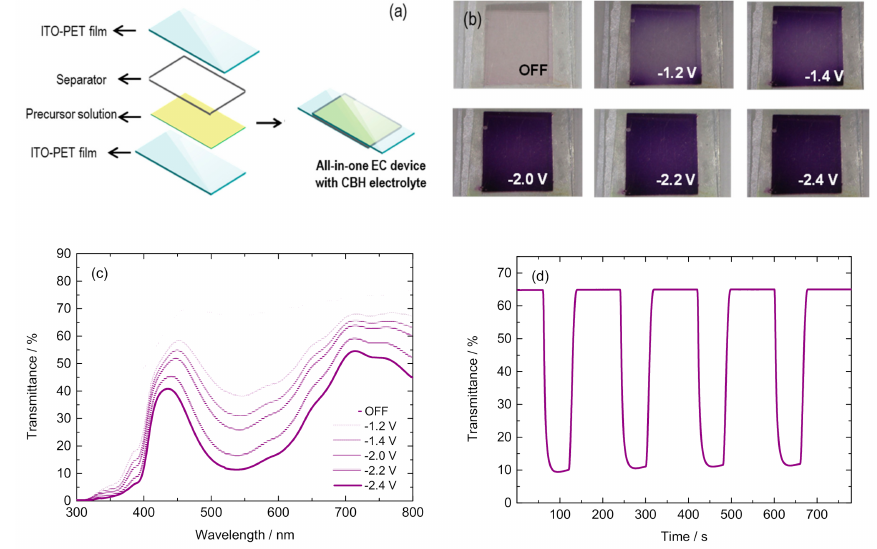
Figure5. Electrochromicperformanceofcellulose-basedhydrogels(CBHs): ( a )schematicrepresentation of the all-in-one electrochromic (EC) device with the flexible poly(ethylene terephtalate) coated with indium tin oxide (ITO-PET); ( b ) pictures at bleached state (OFF) and upon applying di ff erent cathodic potentials (from − 2.4 to − 1.2 V); ( c ) transmittance spectra at bleached state (OFF) and upon applying di ff erent cathodic potentials (from − 2.4 to − 1.2 V); ( d ) transmittance changes (at 550 nm) vs. time with square wave potential steps between bleached (0 V for 120 s) and colored state ( − 2.4 V for 60